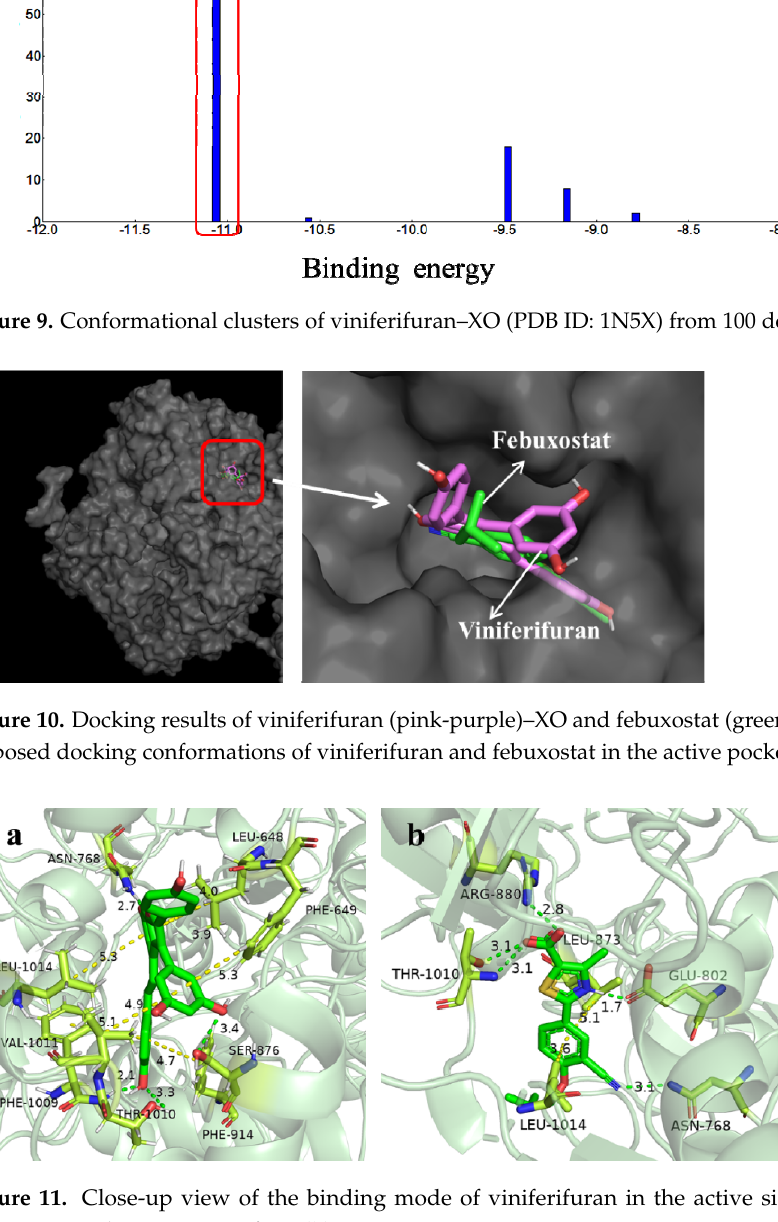
Figure 11. Close-up view of the binding mode of viniferifuran in the active site of XO ( a ) and febuxostat in the active site of XO ( b ). Table 3. The docking results of febuxostat and viniferifuran with 1N5X.